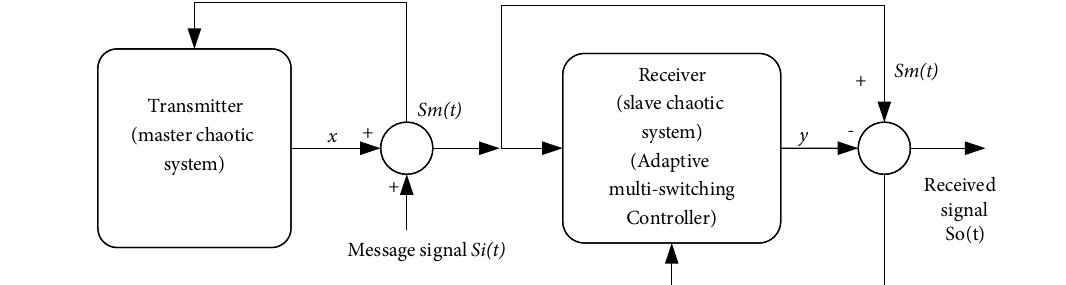
Figure 9: The schematic diagram of hyperchaotic masking secure